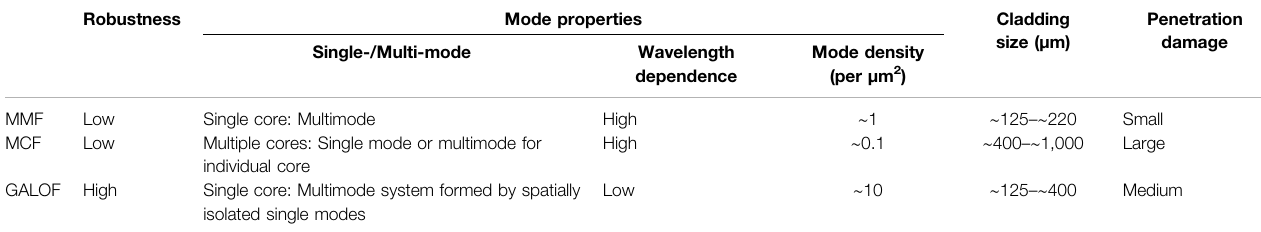
TABLE 1 | Comparison of imaging-related parameters for MMF, MCF and